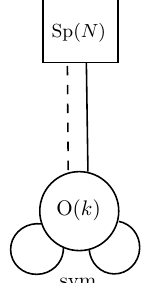
Figure 8 . The solid line represents a hypermultiplet while the dashed line represents a Fermi